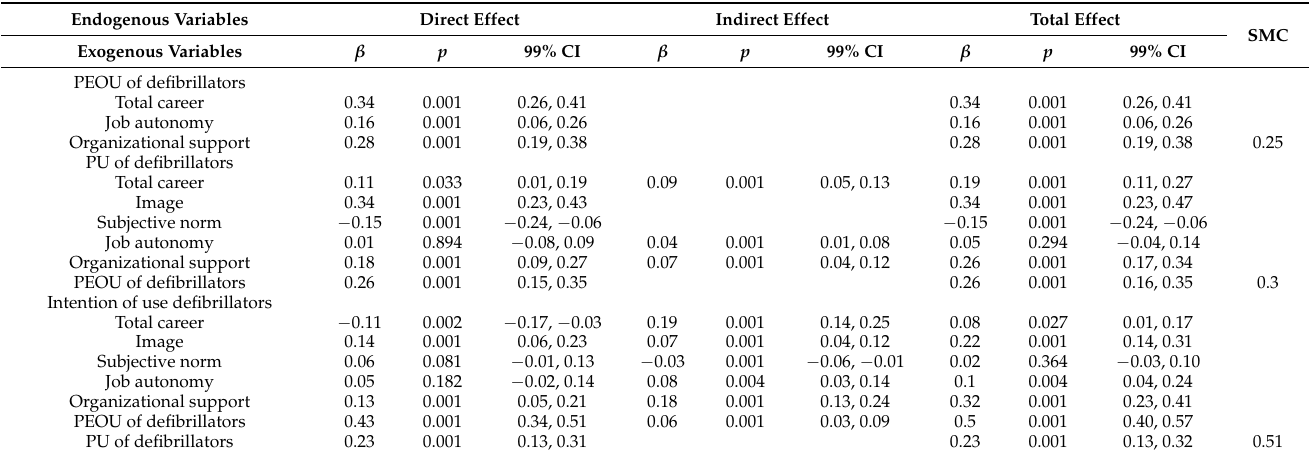
Table 3. Parameter Estimates for Modified Structural Model and Standardized Direct, Indirect, and Total Effect ( N =